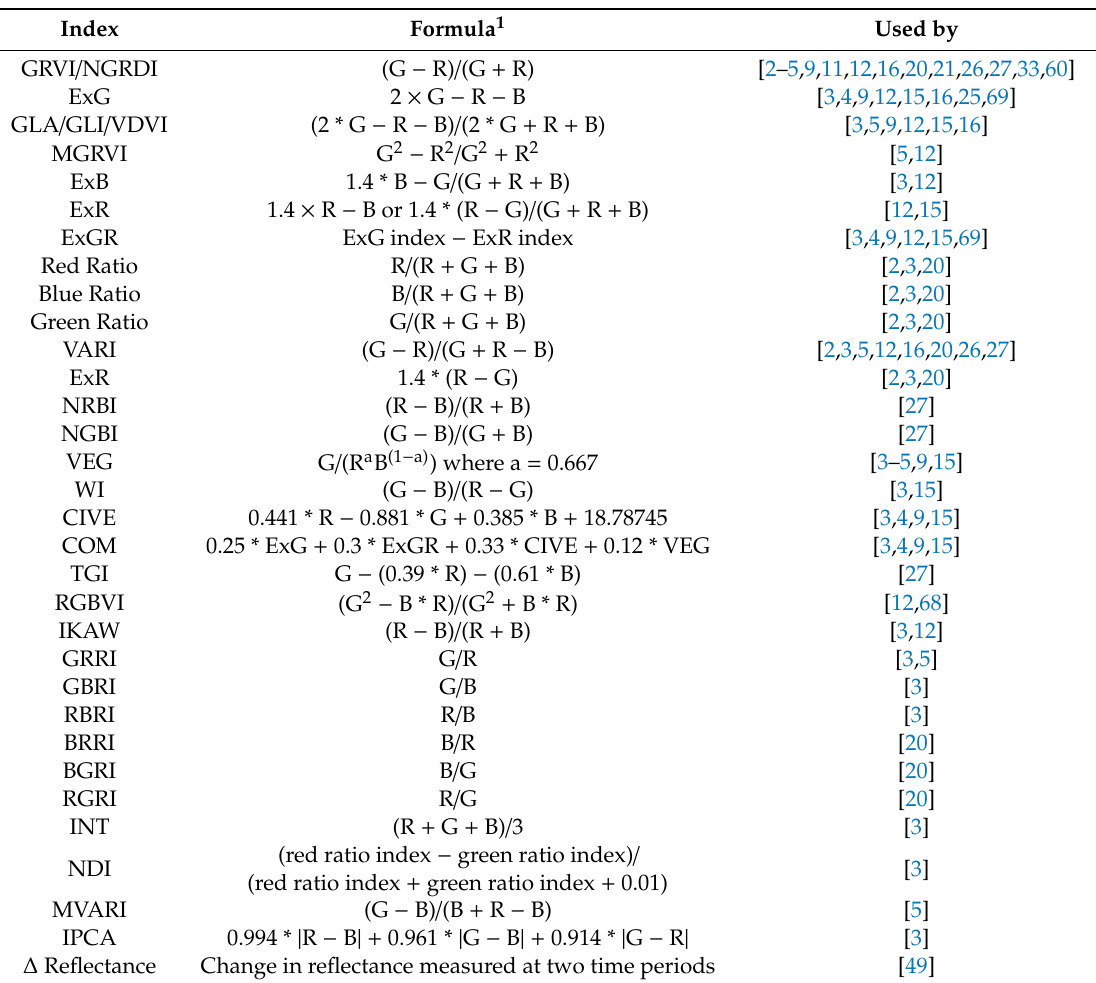
Table 3. All RGB vegetation indices used at least once in vegetation biomass estimation models by studies included in this review. R, G, B and NIR indicate the measured reflectance (digital numbers) in red, green, blue and near-infrared wavelength ranges,